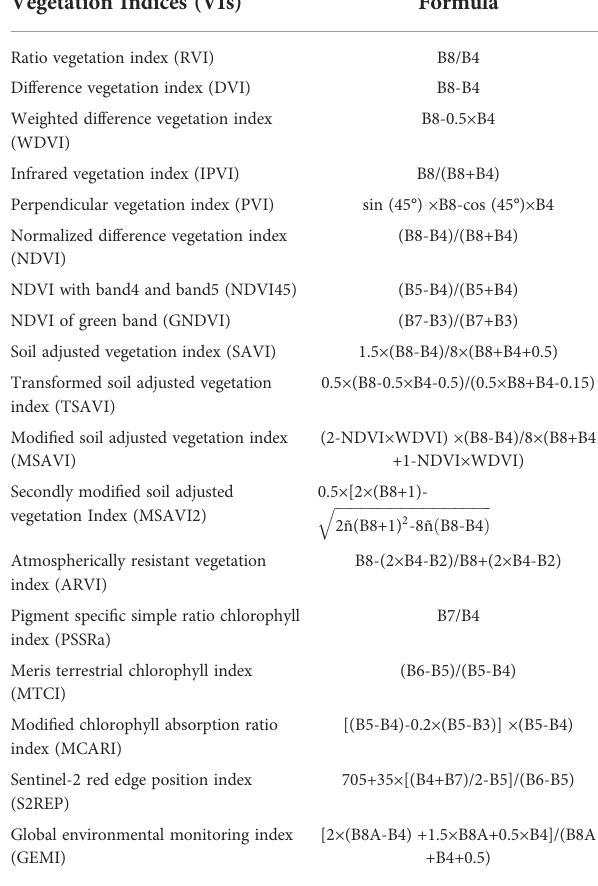
TABLE 3 Selected VIs used for forest parameter estimation.